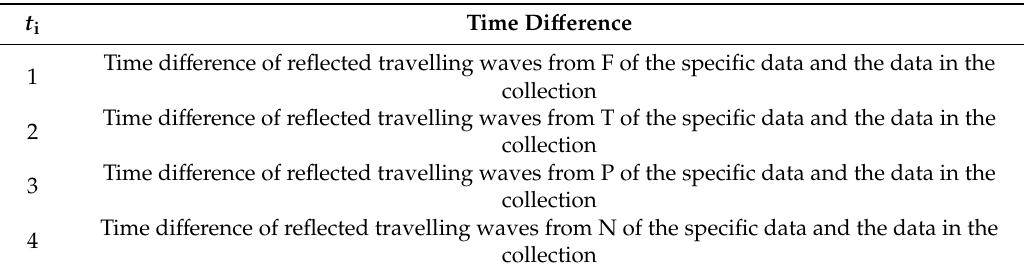
Table 9. Meanings of t